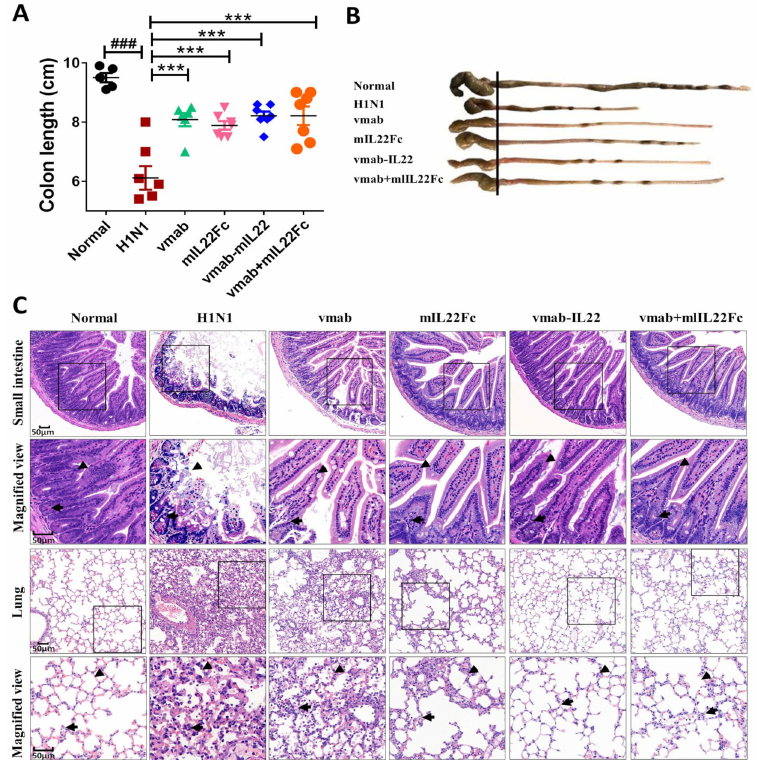
Figure 1. Vmab-mIL22 treatment protects against the lung and gut injury induced by the influenza A virus in mice. Four-week-old BALB/c mice were infected intranasally with the influenza virus at a dose of 2LD 50 /mouse in 30 µ L DMEM ( n = 6 for each group). Treatment was administered intravenously at 2.5 h and 48 h after infection. Mice were sacrificed at 5 days in both groups. ( A ) The length of the colon at day 5 in H1N1-infected mice. ( B ) Representative images of the colon at day 5 in H1N1-infected mice ( C ). Pathological changes in the small intestine and lung were evaluated using H&E staining. Intestinal villi morphology (triangle) and intestinal inflammatory infiltration (arrow) in above; alveolar morphology (triangle) and lung inflammatory cell infiltration (arrow) in below. ### p < 0.001 for comparison of mice in H1N1 group to the normal group, *** p < 0.001 for comparison of mice in treated group to the H1N1